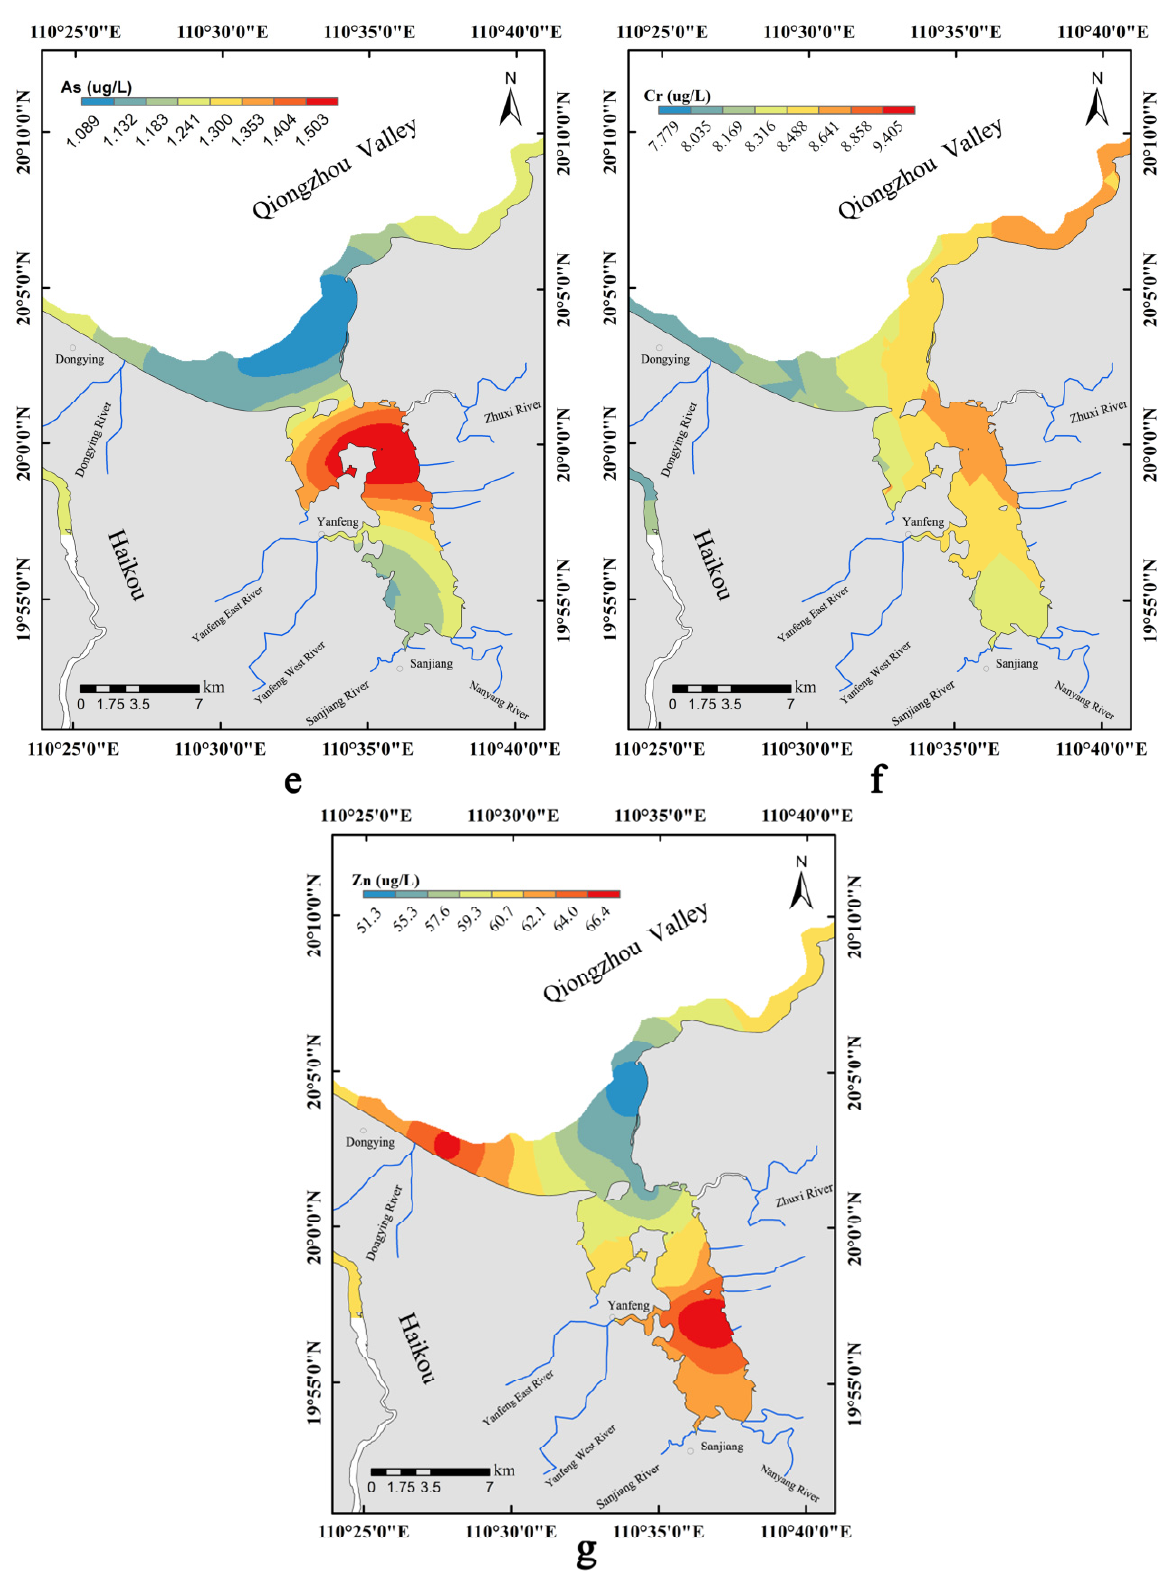
Figure 4. Spatial distribution of heavy metals ( a ) Spatial distribution of Pb; ( b ) spatial distribution of Cd; ( c ) spatial distribution of Hg; ( d ) spatial distribution of Cu; ( e ) spatial distribution of As; ( f ) spatial distribution of Cr; ( g ) spatial distribution of